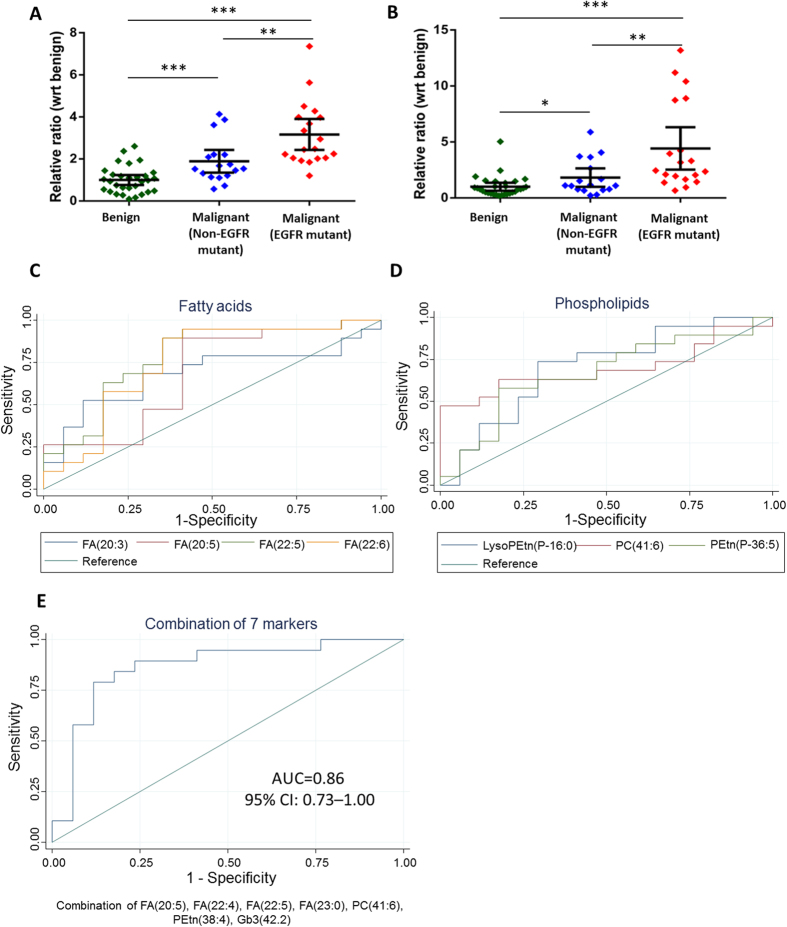
Dot plots describing the relative levels of (A) FA(22:6), (B) FA(20:5) in benign (green), non-EGFR mutant (blue) and EGFR mutant (red) PE samples. p-value calculated based on Mann-Whitney U test, where *denotes p < 0.05, **denotes p < 0.01, ***denotes p < 0.001. ROC curves of non-EGFR mutant versus EGFR mutant subjects for individual PE lipid markers in the class of (C) fatty acids and (D) phospholipids. (E) ROC curves of non-EGFR mutant versus EGFR mutant subjects for an optimal combination of 7 lipid malignancy markers from SVM modelling.